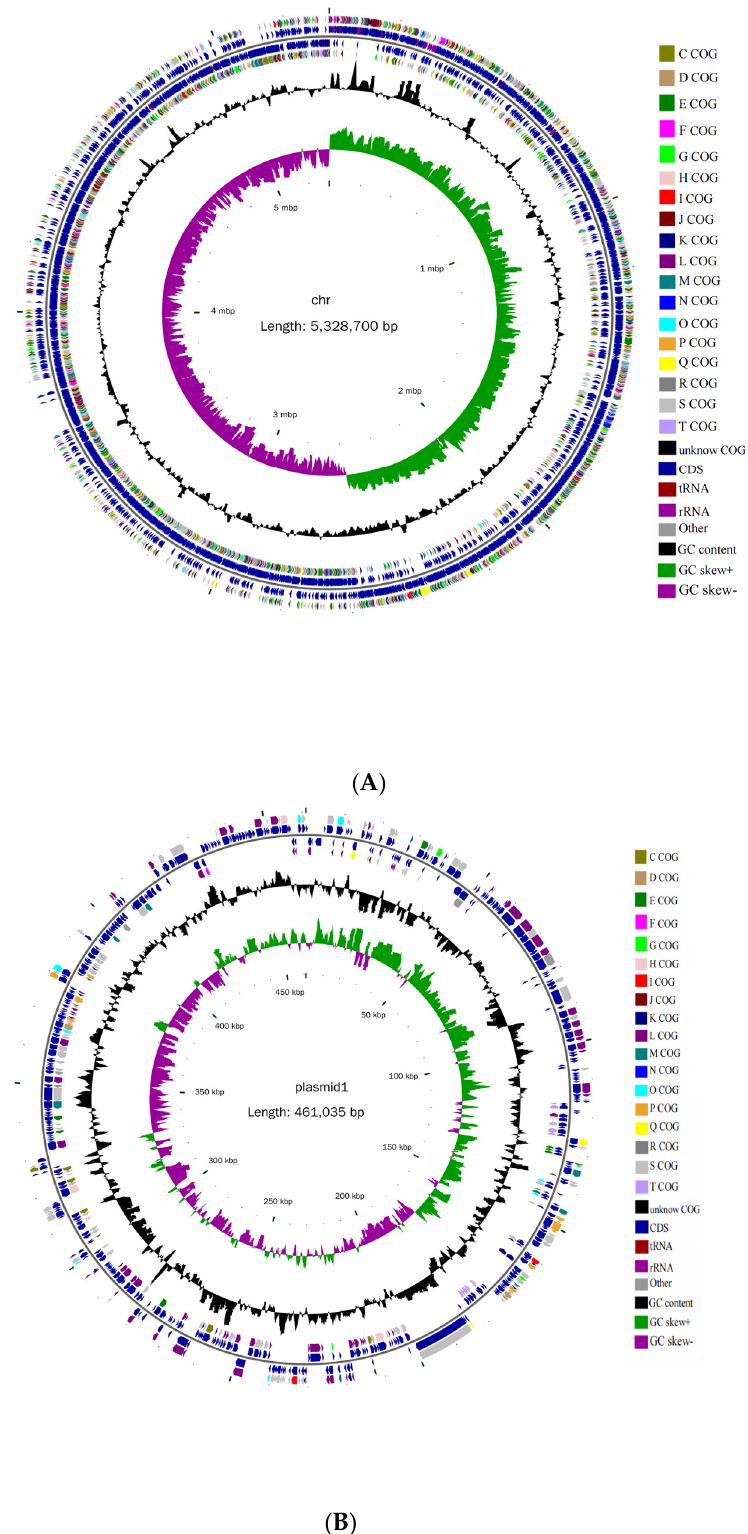
Figure 3. Genomic architecture of B. cereus AH7-7. ( A ) Genome map and ( B ) plasmid map. Each circle, from centre to the outside, represents the following features. The first circle represents the scale mark, the second circle represents GC skew, the third circle represents GC content, the fourth and seventh circles represent every COG to which each coding sequence (CDS) belongs, and the fifth and sixth circles represent the locations of CDS, tRNA and rRNA in the genome.